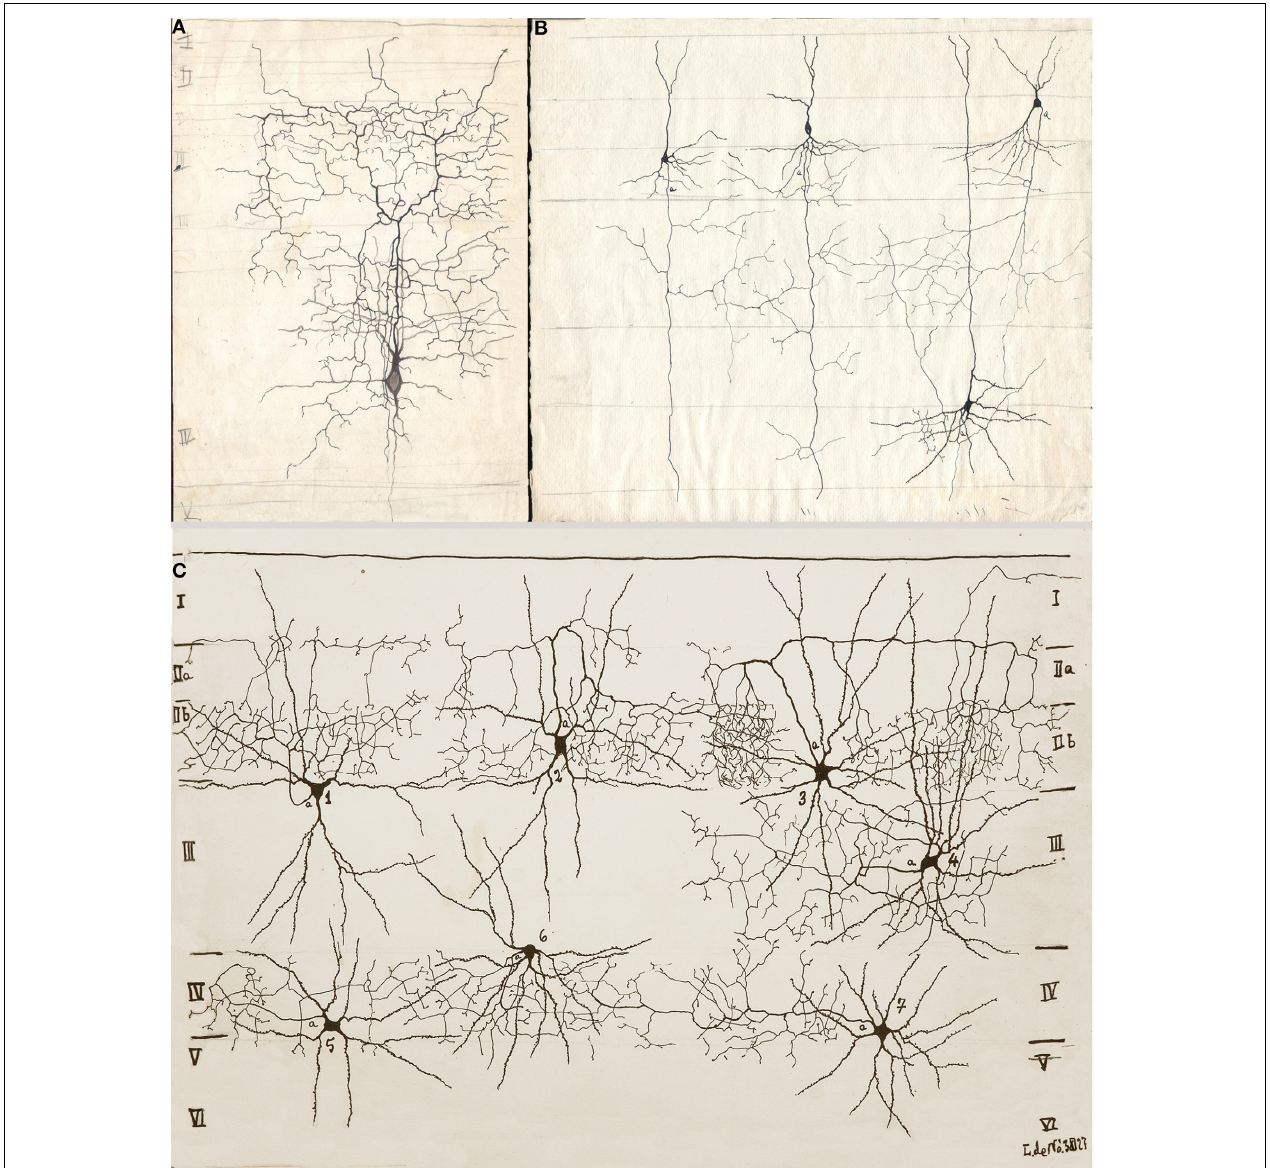
FIGURE 2 | Drawings from Lorente de Nó performed between 1922 and 1927 in the Ramón y Cajal laboratory. (A) Short-axon neuron with an ascending axon that distributes primarily in layer III (III). (B) Three pyramidal cells with numerous axon collaterals to layer IV and an interneuron (upper